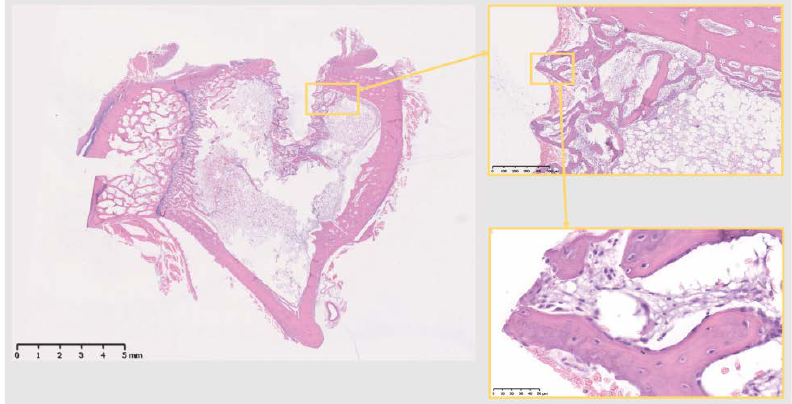
Figure 5. The 10 days Ti site. Bone remodeling and new bone formation around the implant site, isolating it from the marrow space. Scale bars, clockwise: 5 mm, 500 µm and 50 µm.